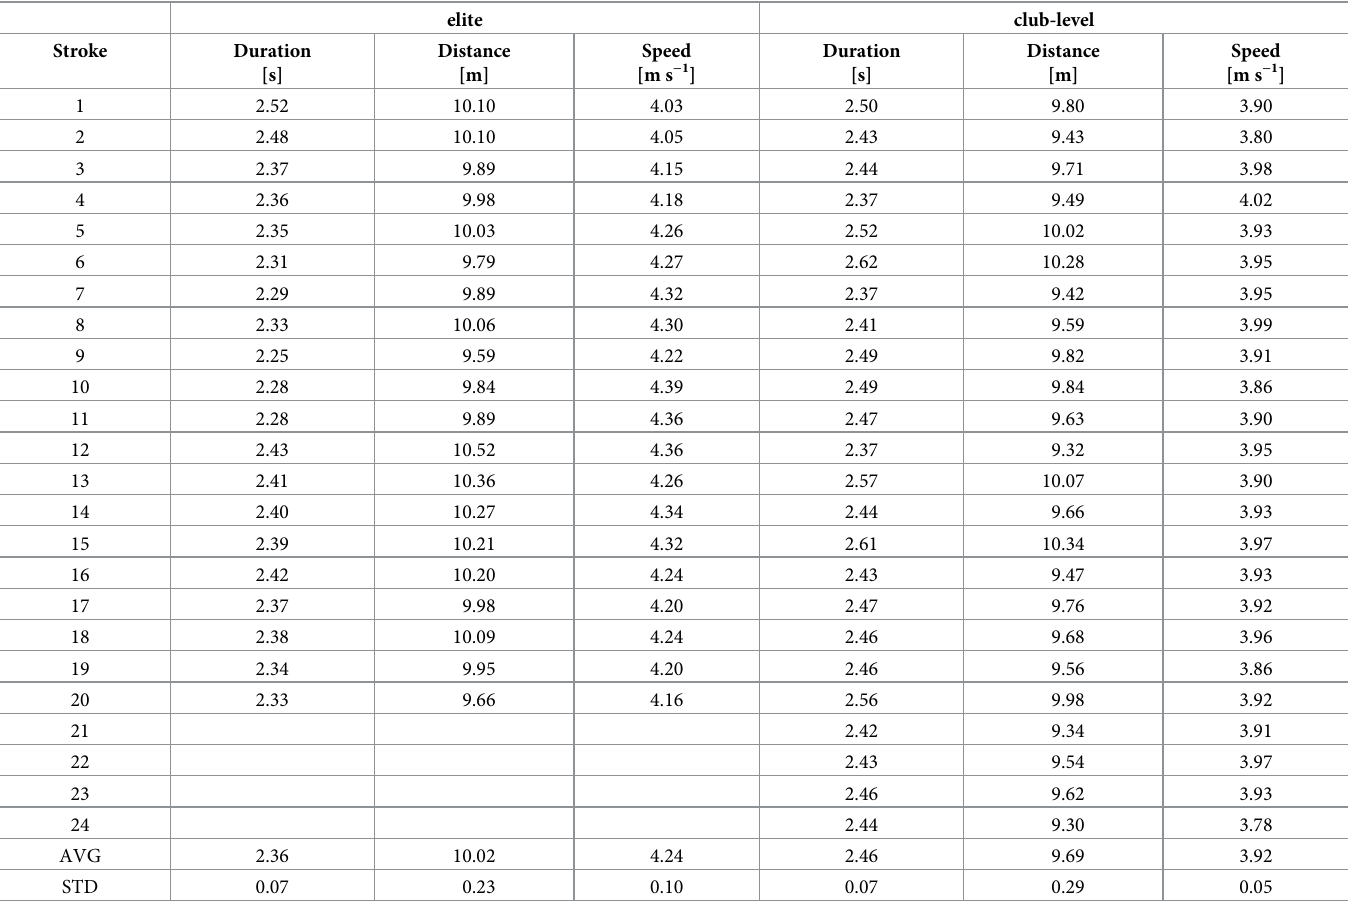
Table 2. Summary DGPS data for strokes from elite and club-level 24SE trials depicted in Figs 3 and